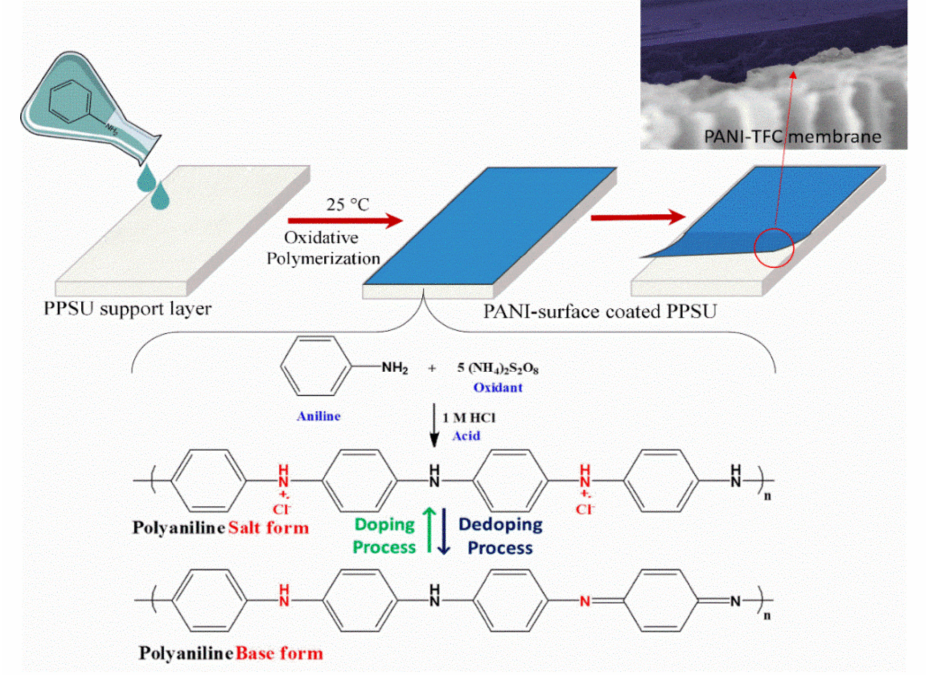
Figure 12. PANI-surface Polyphenylsulfone membrane surface coating via the chemical oxidation of monomeric